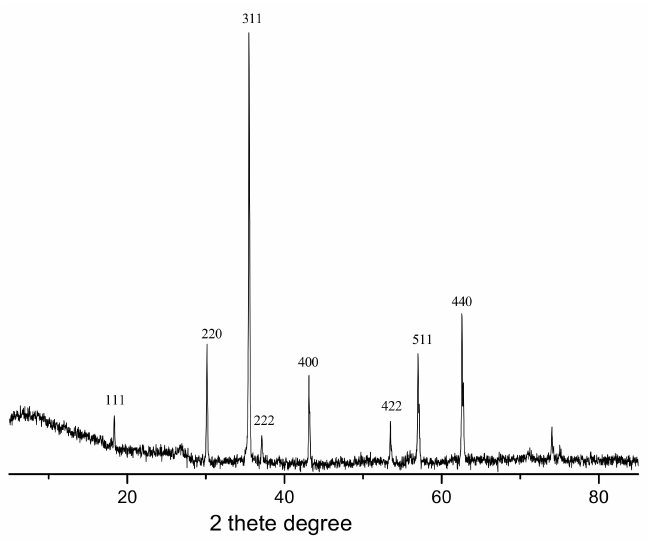
Figure 2. The XRD pattern of the magnetic carbon microtube-based solid